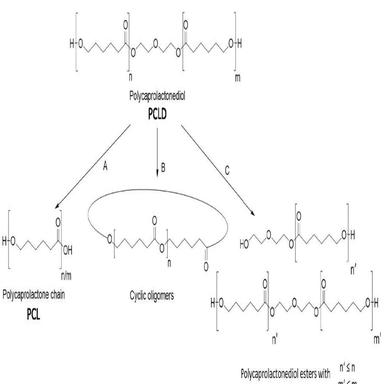
Main degradation products and pathways of polycaprolactonediol (PCLD) polymer (adapted from Rivas et al. 2017).